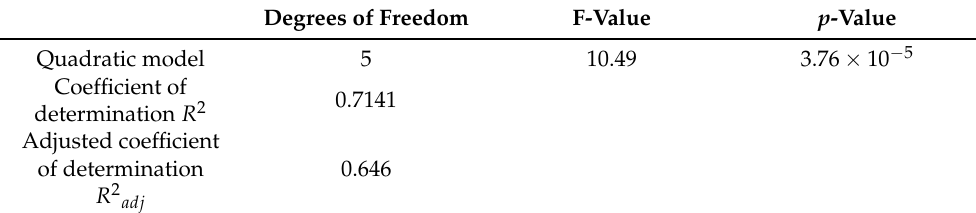
Table 6. Summary quadratic model alkaline-activated